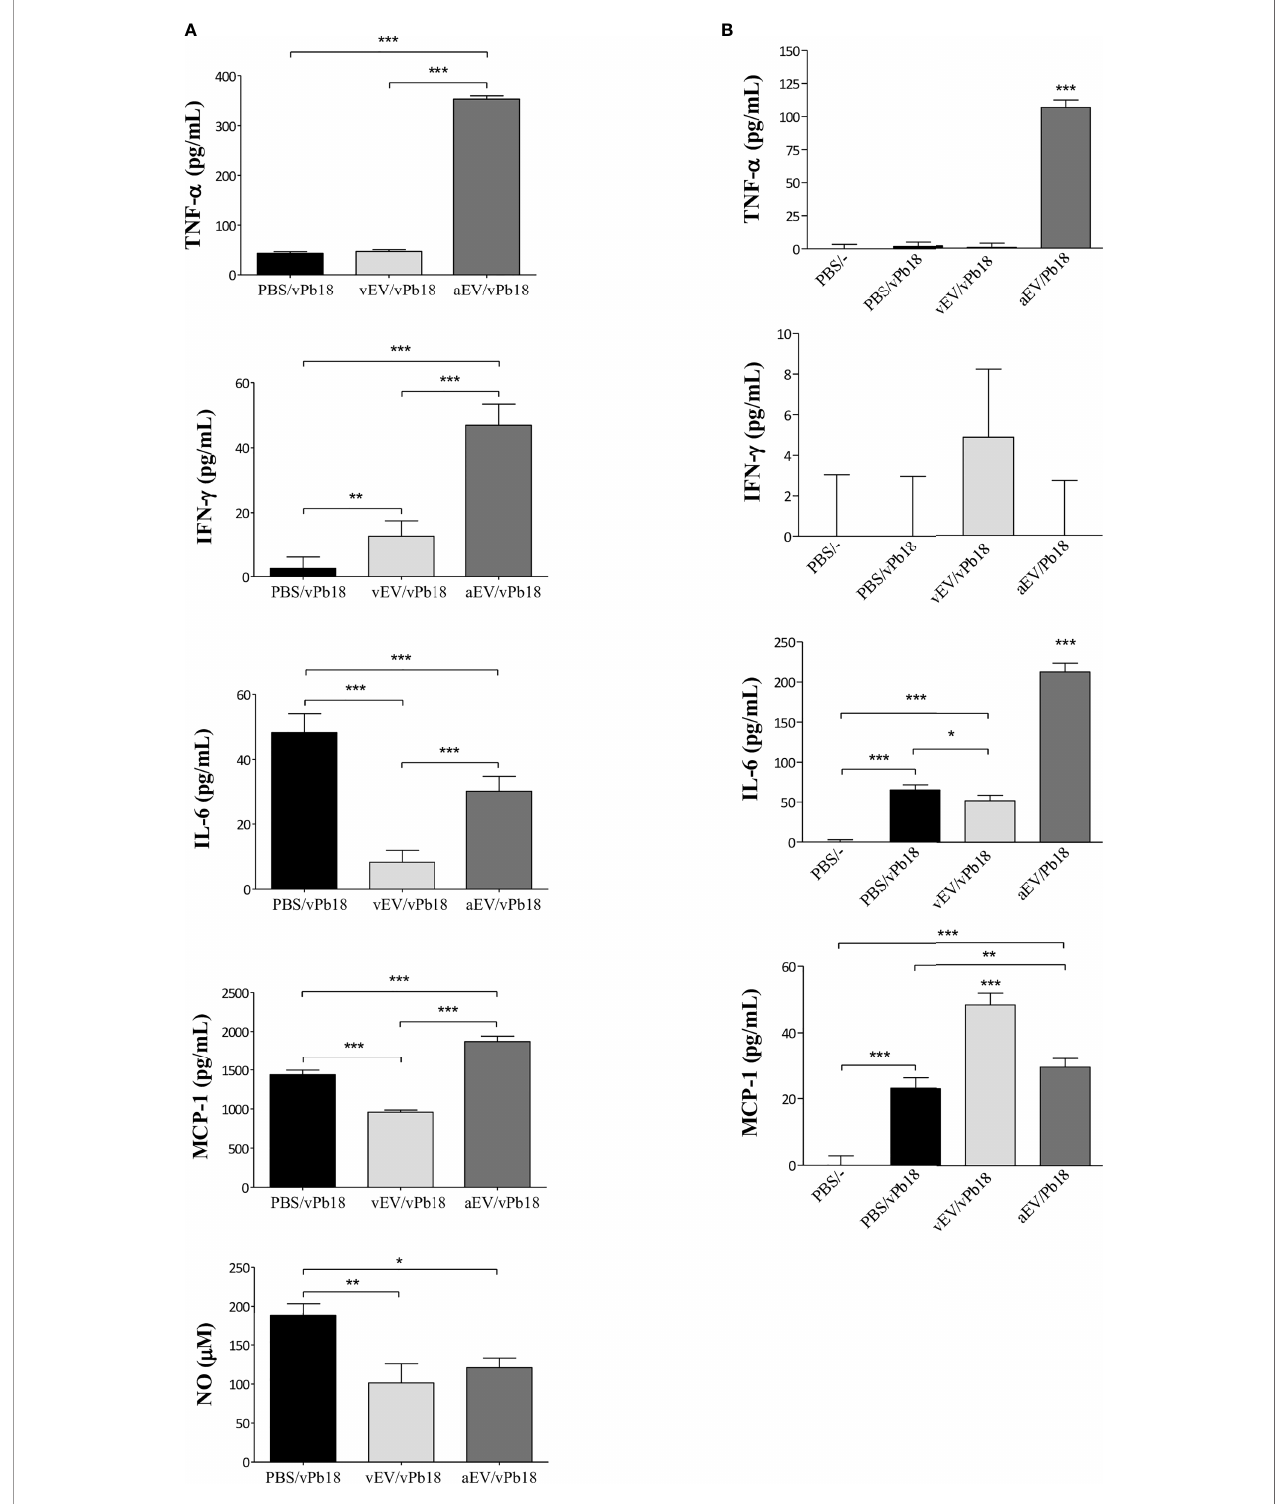
FIGURE 6 | In fl ammatory mediators estimated in mice inoculated with either vEVs (vEV/vPb18) or aEVs (aEV/vPb18) before challenge with P. brasiliensis vPb18, as detailed in Figure 4 . (A) Lung TNF- a , INF- g , IL-6, and MCP-1, and NO concentrations. (B) TNF- a , INF- g , IL-6, and MCP-1 concentrations; PBS/ − , non-infected animals. Standard deviations are shown with bars and signi fi cant results are indicated as * p < 0.05, ** p < 0.01, and *** p <